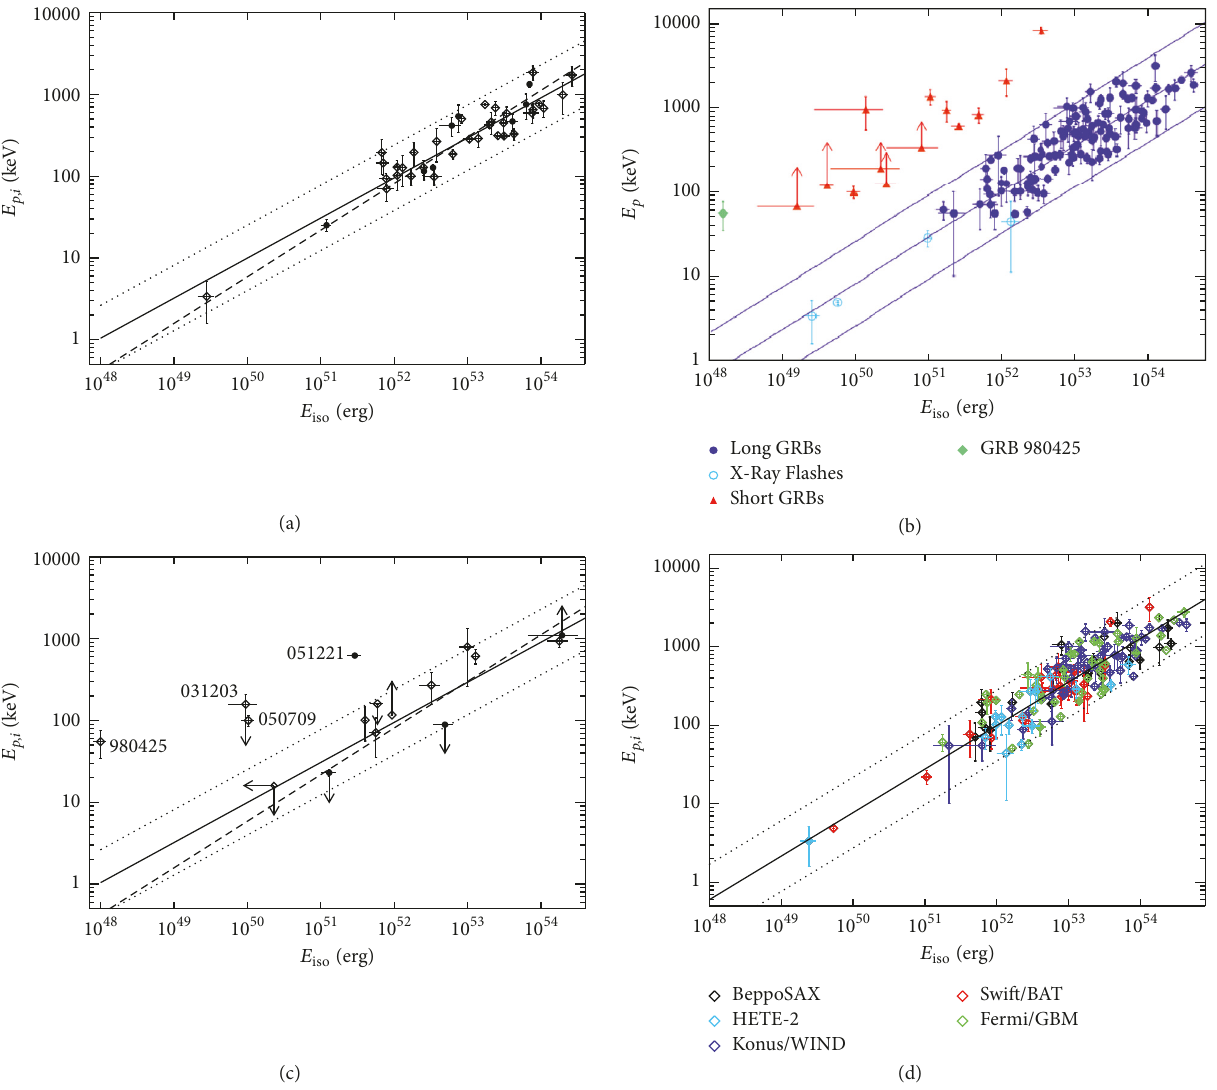
Figure 8: (a) 𝐸 - 𝐸 distribution for 41GRBs/XRFs with measured redshifts and 𝐸 values. Filled circles indicate Swift GRBs. The solid peak iso peak = 1.98 + 0.49 log 𝐸 line represents the best-fit line log 𝐸 ; the dotted lines show the region within a vertical logarithmic deviation of 0.4. peak iso = 1.89 + 0.57 log 𝐸 The dashed line represents the best-fit line log 𝐸 computed without taking into account the sample variance. (Figure peak iso after Amati [190]; see Figure 2 therein.) (b) The distribution of the sample in the 𝐸 - 𝐸 plane. The lines indicate the best-fit line and the peak iso ±2𝜎 confidence region for LGRBs and XRFs. (Figure after Amati [193]; see Figure 4 therein. Copyright @ 2012 World Scientific Publishing Company.) (c) 𝐸 - 𝐸 distribution of 12GRBs with uncertain values of 𝑧 and/or 𝐸 , for the subenergetic event GRB980425 and for the peak iso peak = 1.98 + 0.49 log 𝐸 two SGRBs 050709 and 051221. Filled circles represent Swift GRBs. The solid line is the best-fit line log 𝐸 ; the dotted peak iso = 1.89 + 0.57 log 𝐸 lines mark the region within a vertical deviation in logarithmic scale of 0.4. The dashed line is the best-fit line log 𝐸 peak iso computed without taking into account the sample variance. (Figure after Amati [190]; see Figure 3 therein.) (d) The 𝐸 - 𝐸 distribution peak iso for the LGRBs. The black line represents the best-fit line and, for each point, the color indicates the instrument which performed the spectral measurement. (Figure after Amati and Valle [197]; see Figure 4 therein. Copyright @ 2013 World Scientific Publishing Company.)